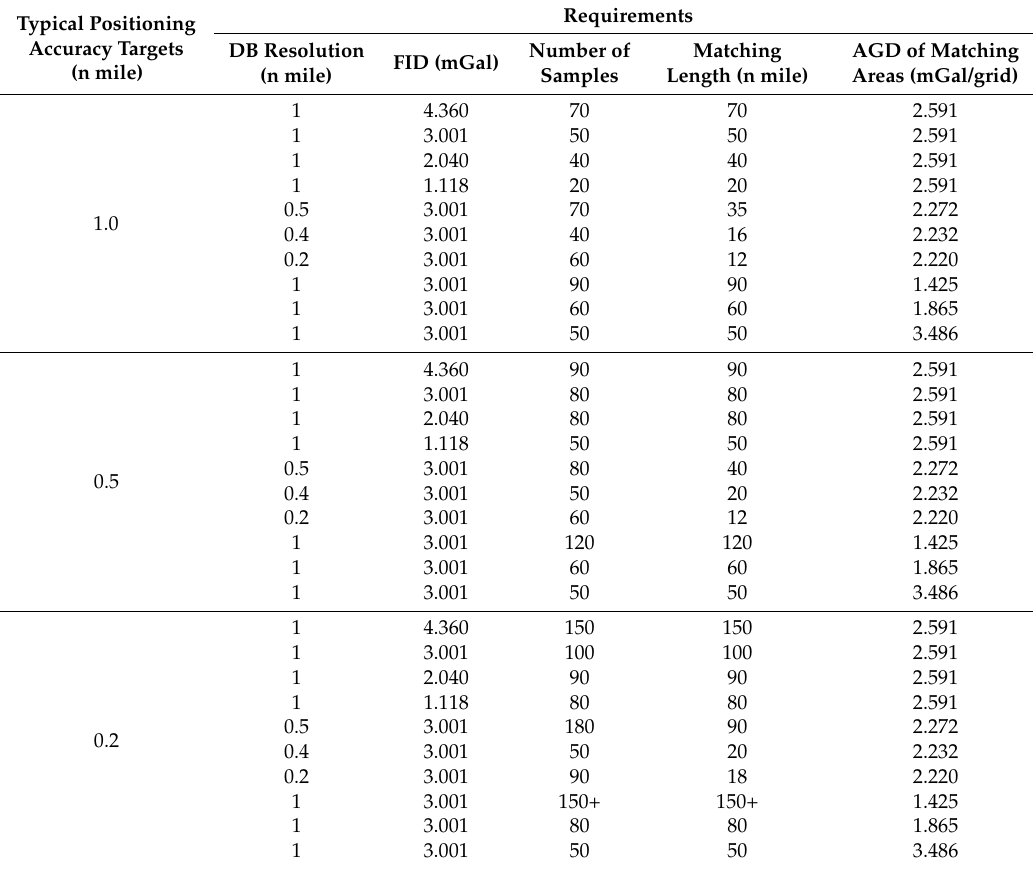
Table 3. GMAN system requirements for typical positioning accuracy